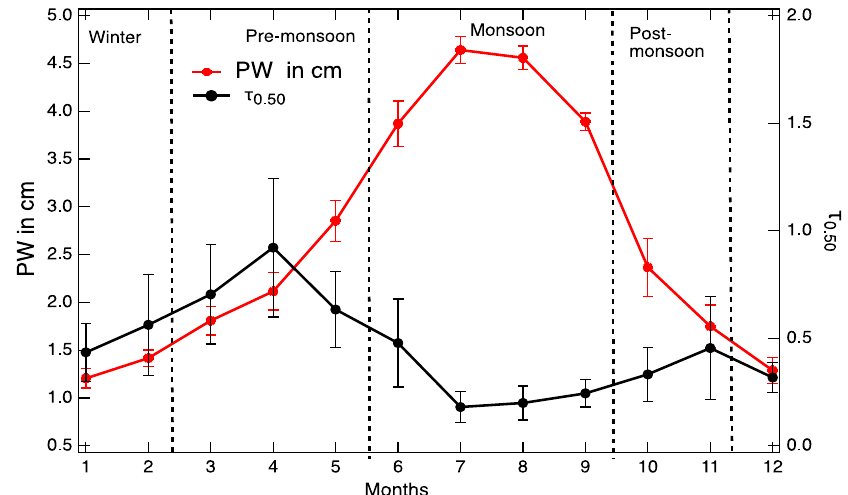
Figure 3. Temporal variation, monthly mean τ 0.50 (right axis), and precipitable water level in cm (left axis). The vertical dotted lines indicate the boundaries between different seasons.